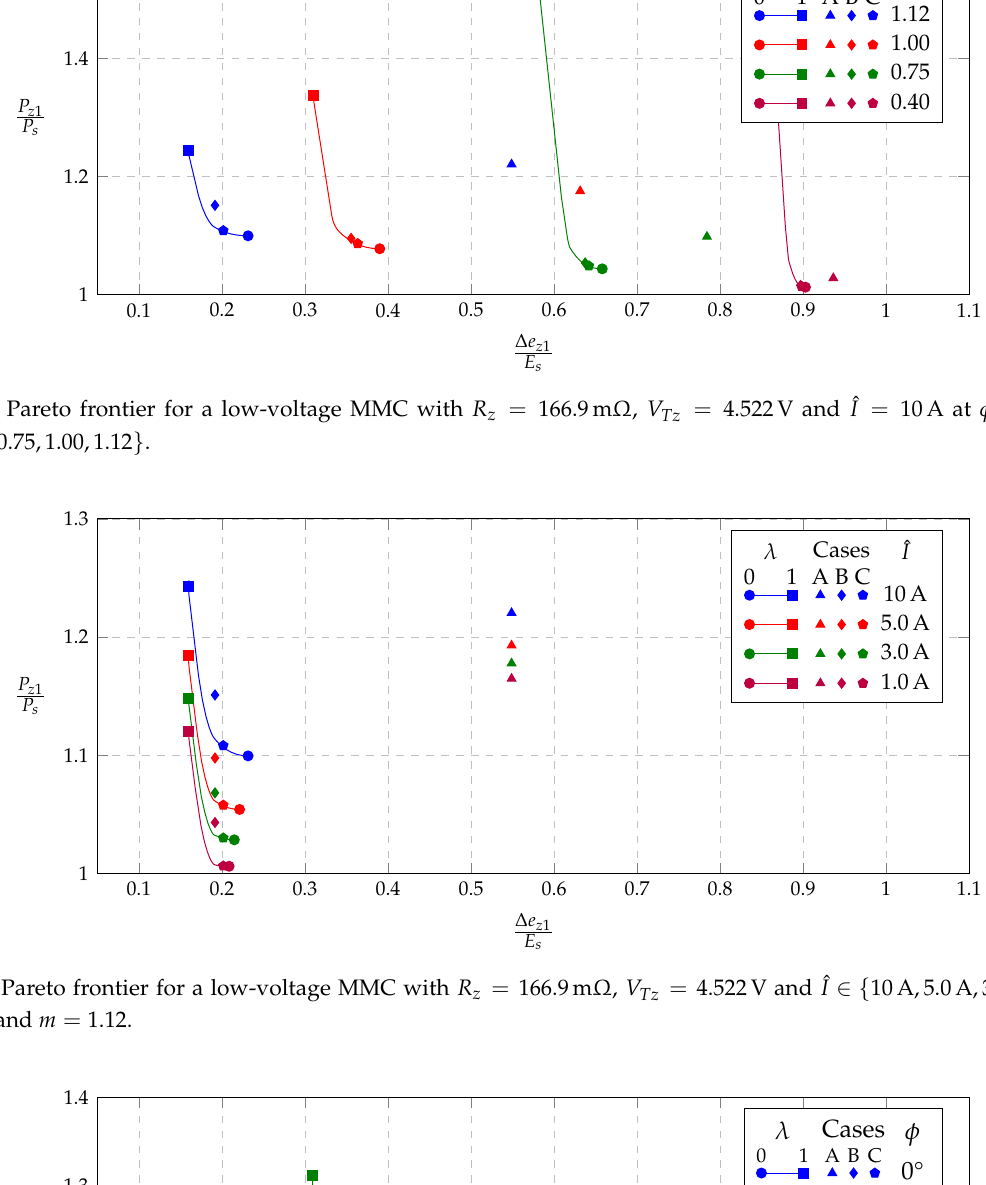
Figure 4. Pareto frontier for a low-voltage MMC with R z = 166.9m Ω , V Tz = 4.522V and ˆ I at φ = 0° and m = 1.12.